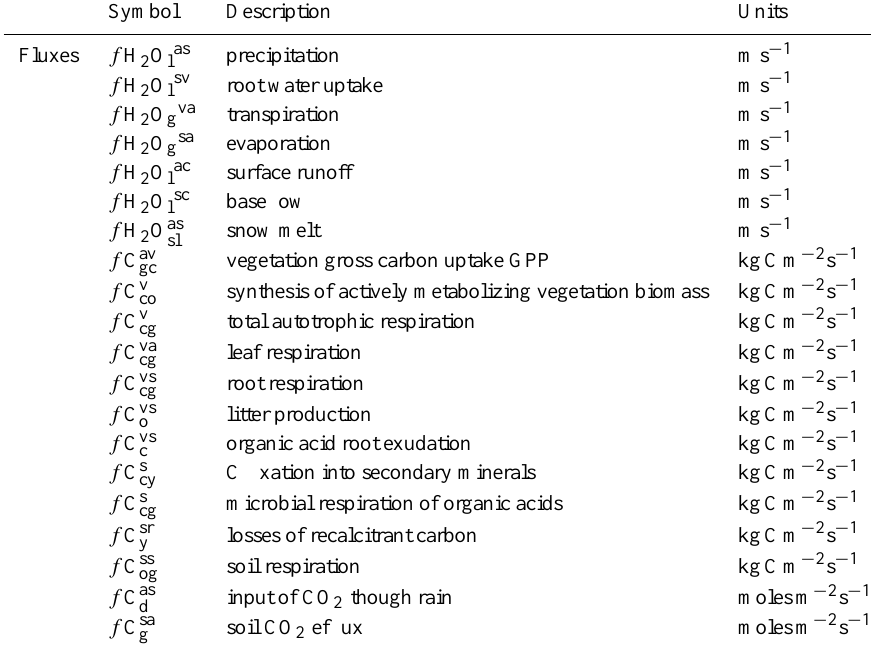
Table A2. Description of model variables relevant for the P cycle (part 2 of